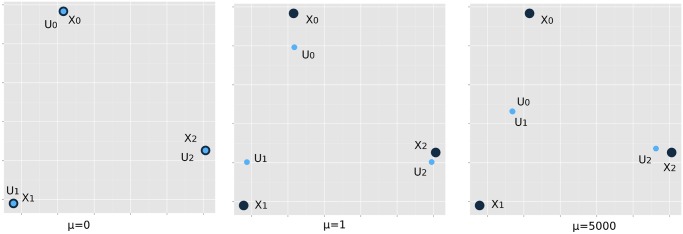
Convex clustering concepts.For clarity, we present three random data points extracted from the three classes in the Iris dataset. Black points denote the original data points X and blue points denote the cluster centers U. At μ = 0, X and U coincide. At intermediate μ values (middle figure), U coalesces towards its cluster center. For sufficiently large μ, U converges to cluster centers (right figure). Note that in this demonstration, only the left two points have non-zero pairwise weights w
ij. Hence, the two resulting clusters reflect the two graphs defined by the matrix of weights.